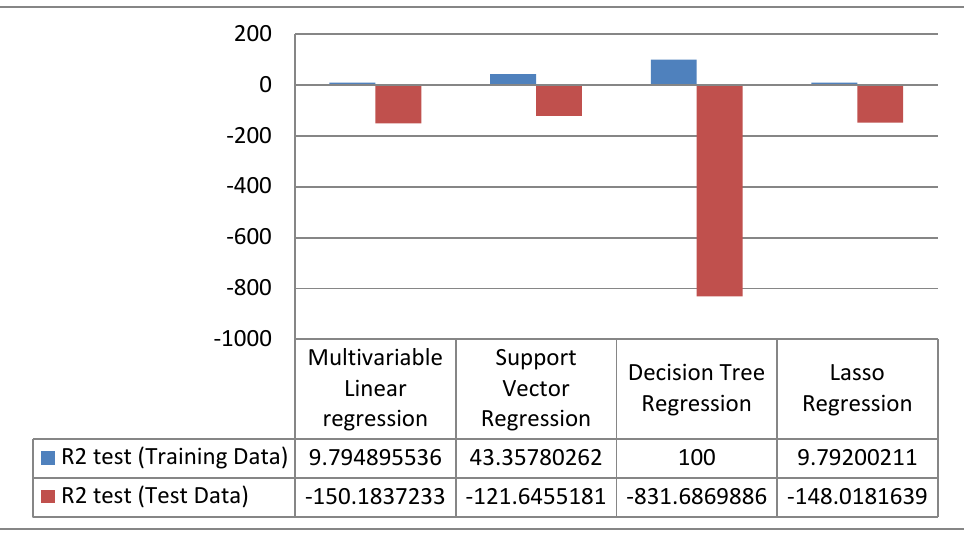
Figure 7. R 2 result for Hardness.